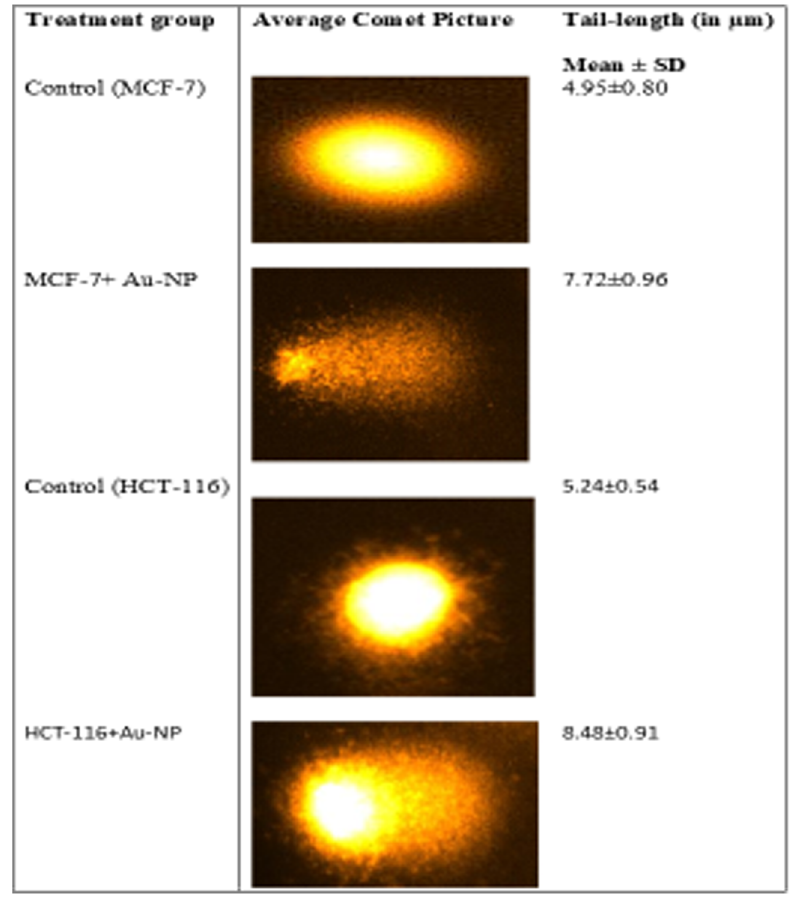
Figure 5: Comet assay was used to evaluate the DNA damage caused by AuNPs ( 5 µg/mL ) in the studied cancer cells. The results showed a signi fi cant DNA damage caused by AuNPs treatment, as observed by increase in the tail length of DNA in cancer